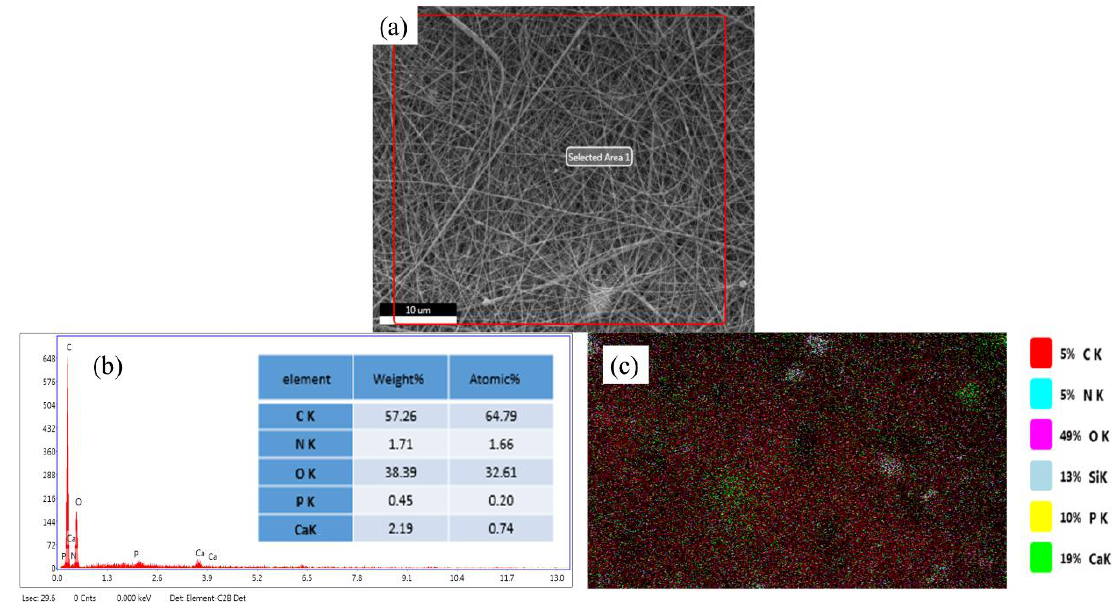
Figure 2. ( a ) SEM ( b ) Energy-dispersive X-ray spectroscopy (EDS) area analysis and ( c ) EDS map analysis of the 3BG/GE/PCL composite coating.